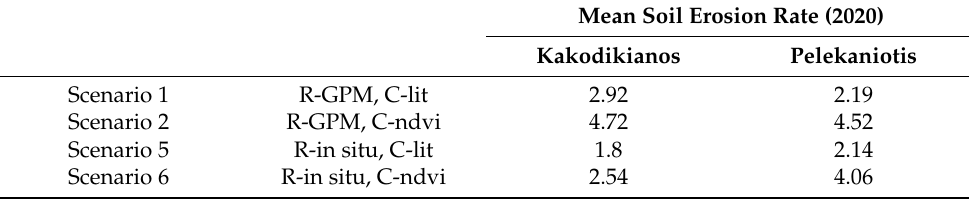
Table 15. Mean soil erosion rates for each catchment.